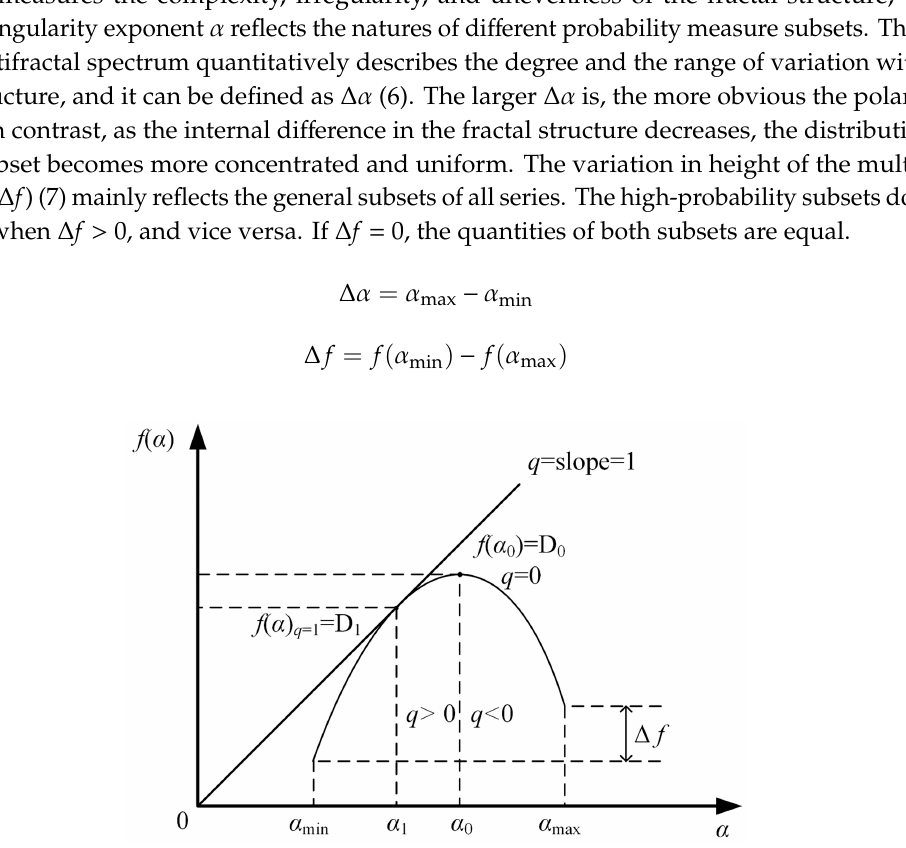
Figure 2. Typical multifractal spectrum diagram.